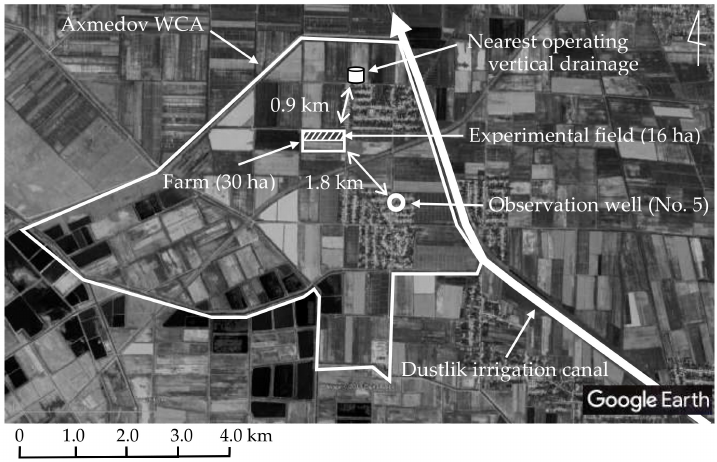
Figure 2. Location of the experimental field in Axmedov WCA. The figure shows the location of the nearest operating vertical drainage, observed well outside of the farm and the main irrigation canal, referred to as Dustlik irrigation